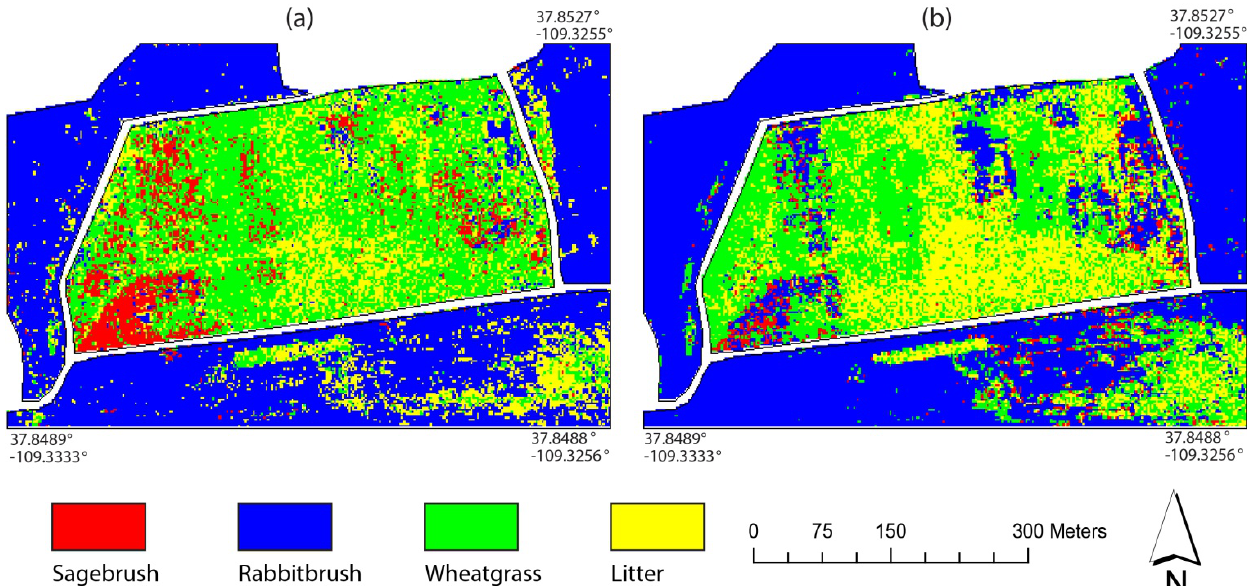
Figure 10. The vegetation species distribution maps for the Monticello site based on the decision trees ( a ) using the MTMF-derived metrics and vegetation indices, and ( b ) using the original scaled reflectance data. The road and other land cover classes were masked